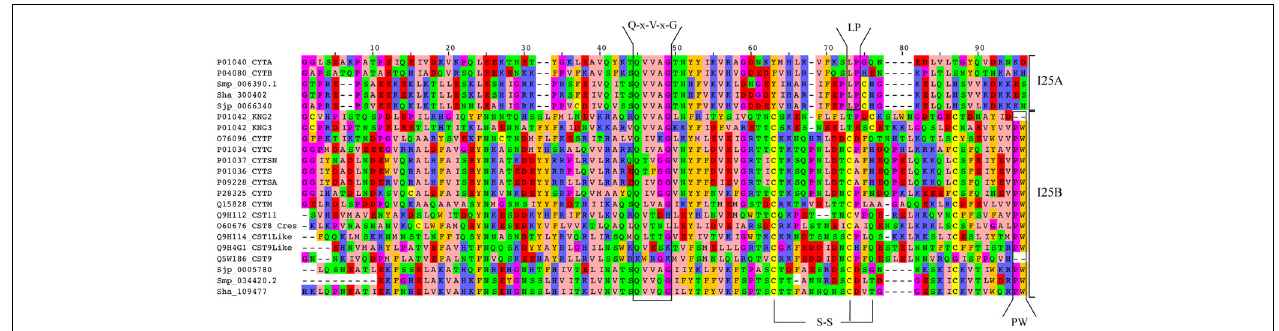
FIGURE 3 | Alignment of Schistosoma and human homologs. Multiple sequence alignment of the conserved domain (PF00031) of I25A and I25B proteins of S. haematobium (Sha), S. japonicum (Sjp), S. mansoni (Smp), and